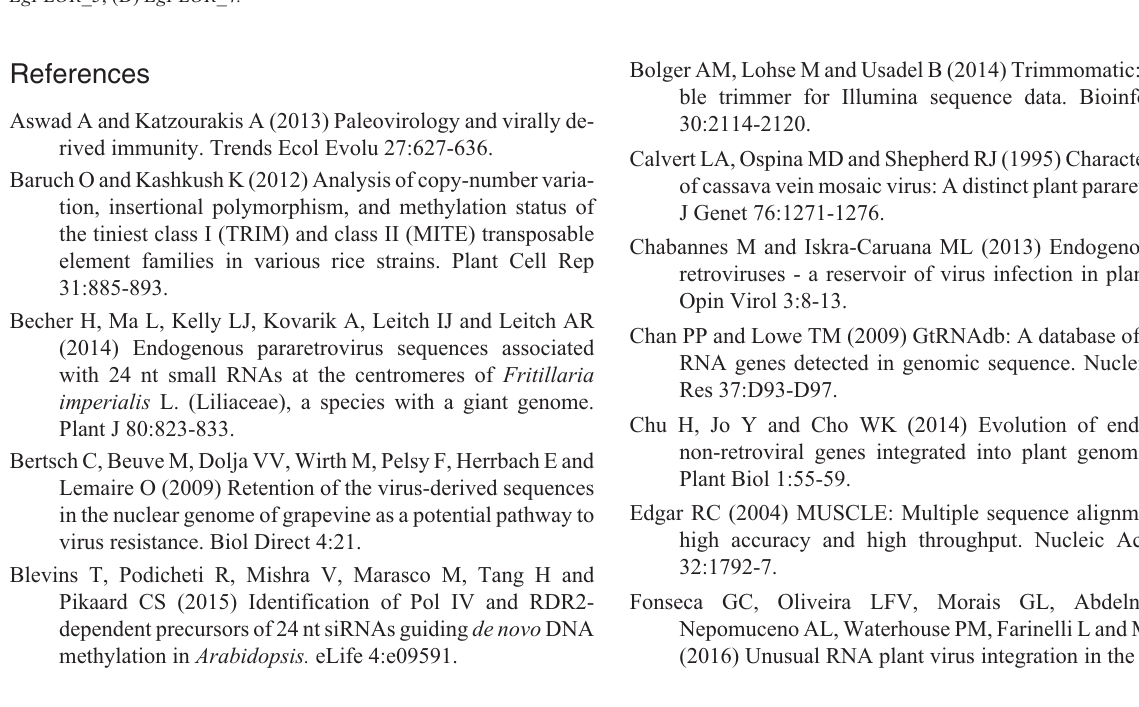
Figure 5 - Eucalyptus grandis small RNA reads distribution along EVE reference sequences. (A) EgEVE_1 , (B) EgFLOR_1 , (C) EgFLOR_2, (D) EgFLOR_3 , (D)